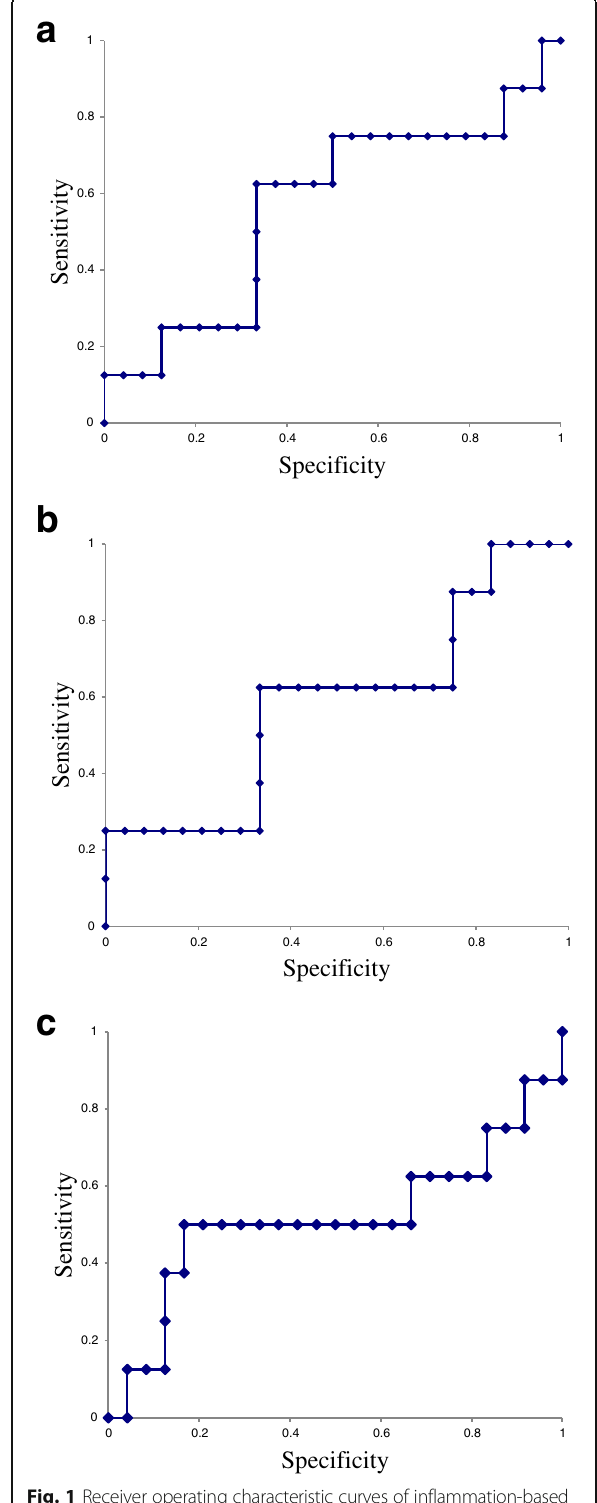
Fig. 1 Receiver operating characteristic curves of inflammation-based prognostic scores for predicting mortality. a NLR. b PLR. c